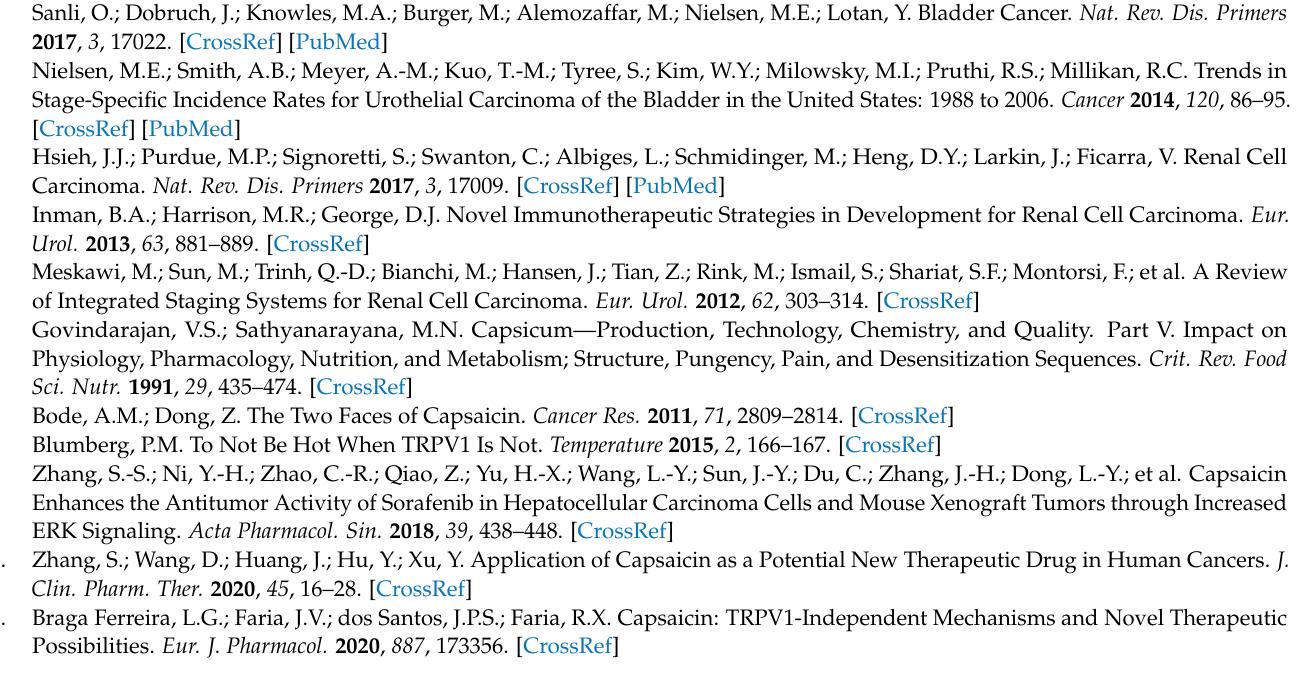
cell death; Figure S2: TRPV1 silencing in 5637 and T24 cell lines, Figure S3: CPS does not influence ROS production; Figure S4: CPS does not influence mitochondrial transmembrane potential, Figure S5: Full Western blot for Figure 1, Figure S6: Full Western blot for Figure 2, Figure S7: Full Western blot for Figure 4, Figure S8: Full Western blot for Figure 5, Figure S9: Full Western blot for Figure 6, Figure S10: Full Western blot for Figure 7, Figure S11: Full Western blot for Figure